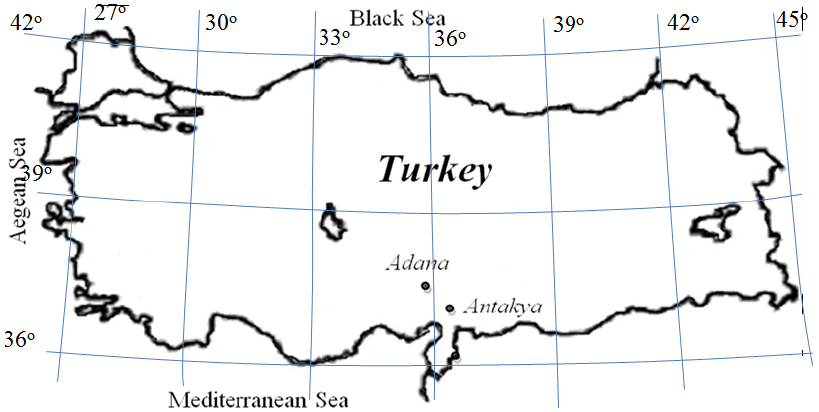
Figure 1. The studied stations in the Mediterranean region of Turkey; Adana and Antakya. In Figure 2, the general characteristics of the independent variables and the target value for the (a) Adana and (b) Antakya stations are shown using the box-whisker plot and related correlation values. These plots graphically depict the variability of each pa- rameter in terms of minimum, quartiles, and maximum values. Moreover, outliers are plotted as individual points.